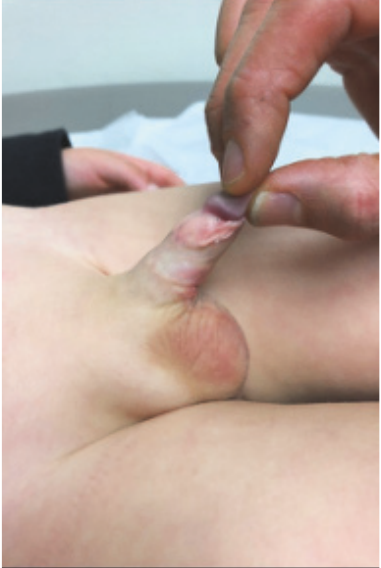
Figure 5: Demonstration of excellent cosmesis at eleven-month